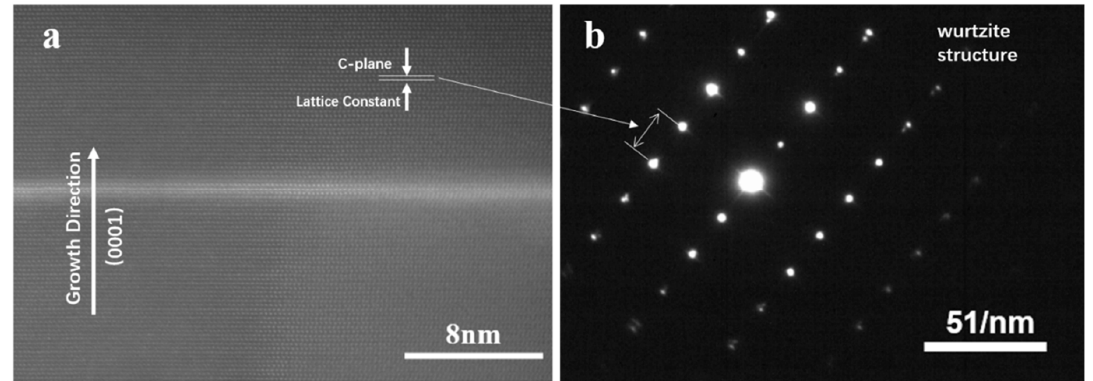
Figure 3. ( a ) HAADF-STEM image of the GaN quantum disk in a single nanowire. ( b ) Selected area electron diffraction (SAED) of the corresponding area of ( a ).